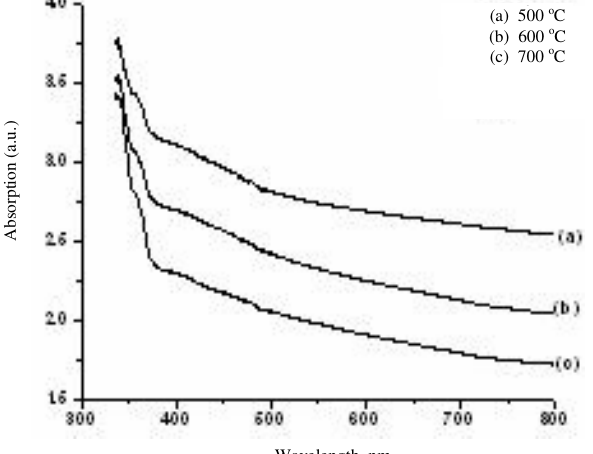
Figure 7. UV-Vis absorption spectra of the as-prepared NiTiO